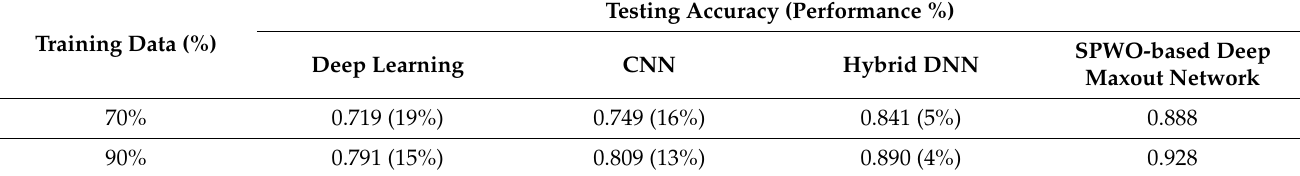
Table 8. The Analysis of Testing Accuracy.